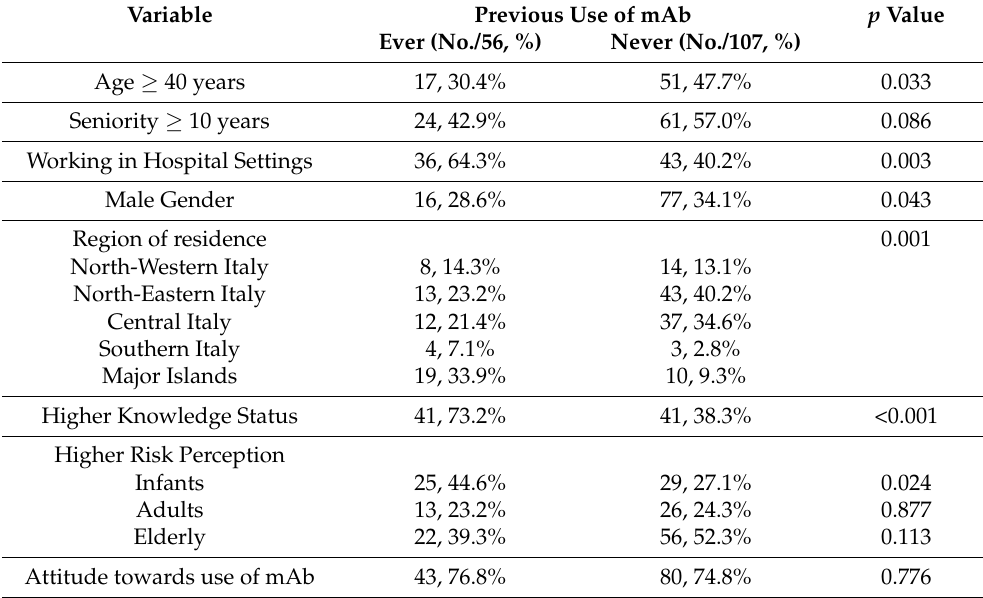
41, 73.2% 41, 38.3% <0.001 Infants 25, 44.6% 29,